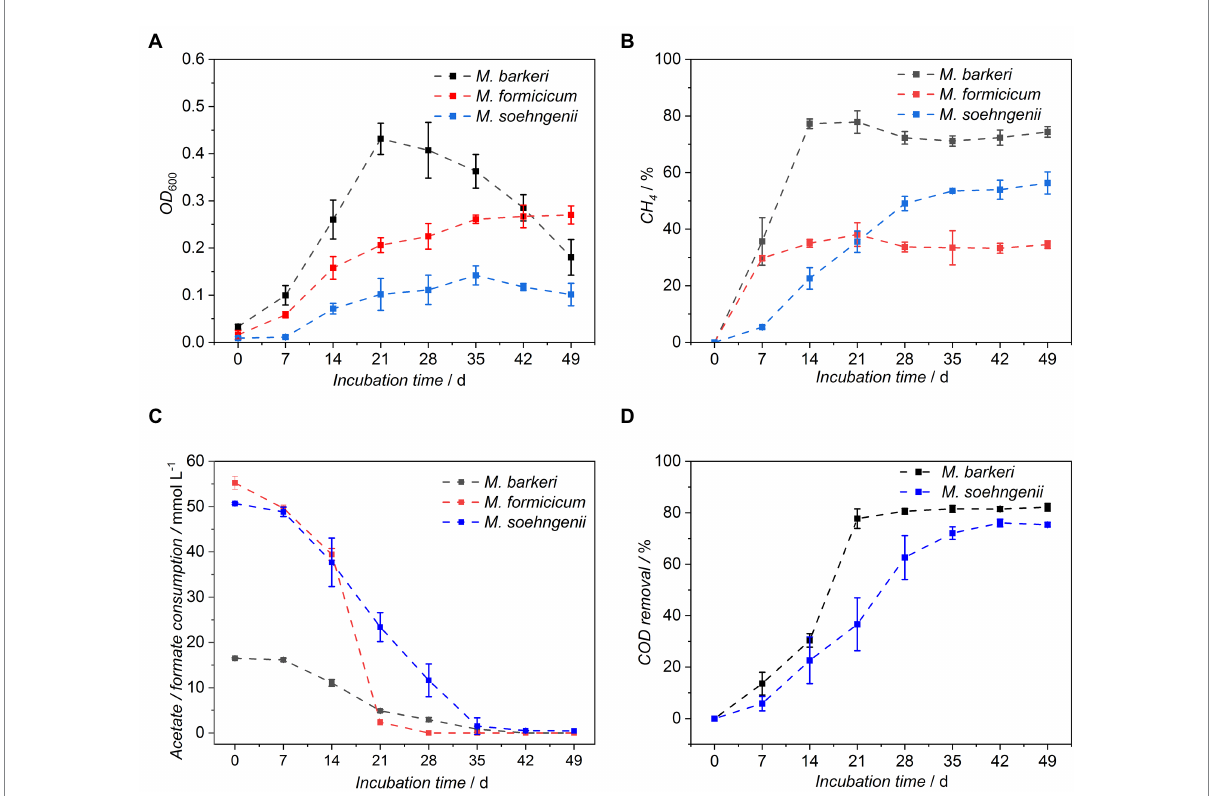
FIGURE 2 Growth characteristics of Methanosarcina barkeri , Methanobacterium formicicum , and Methanothrix soehngenii in the BFS01 medium: (A) OD 600 , (B) CH 4 concentration in the headspace of the cultures, (C) acetate (blue and black dots) and formate (red dots) consumption, (D) COD removal, error bars indicate CI, n =